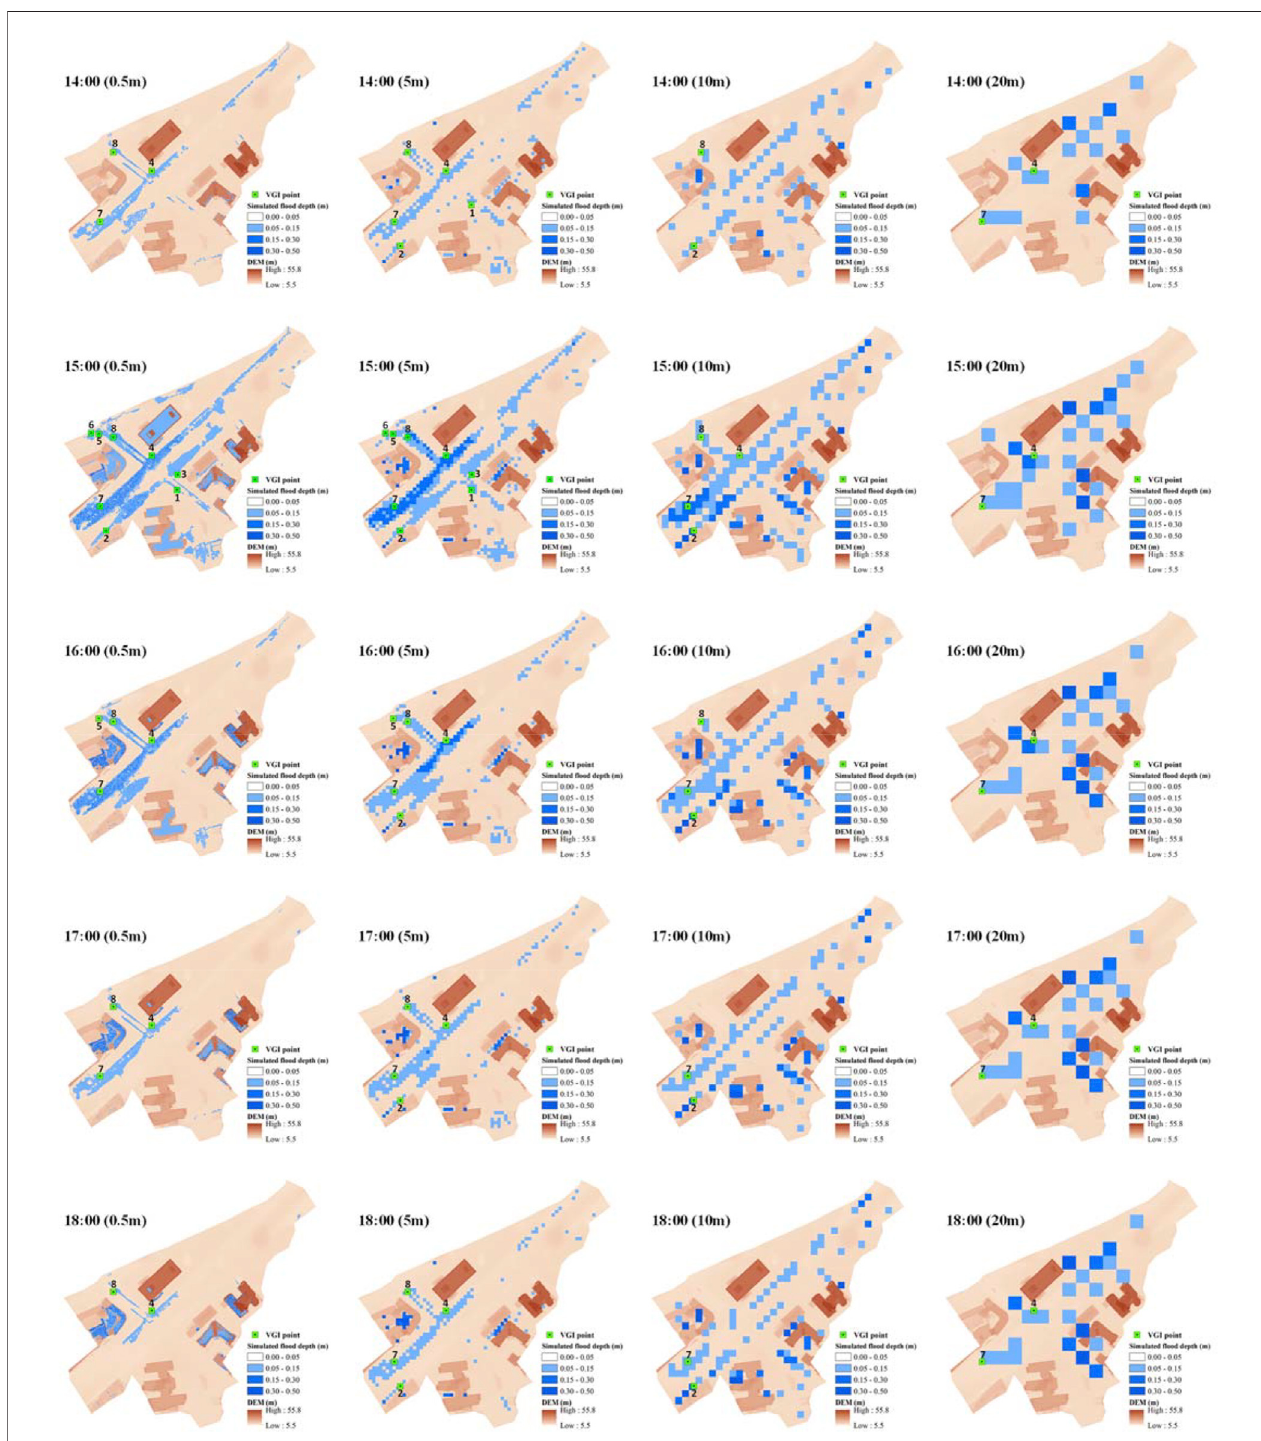
FIGURE 8 | Simulated fl ood extents at different time under four DEM resolutions.